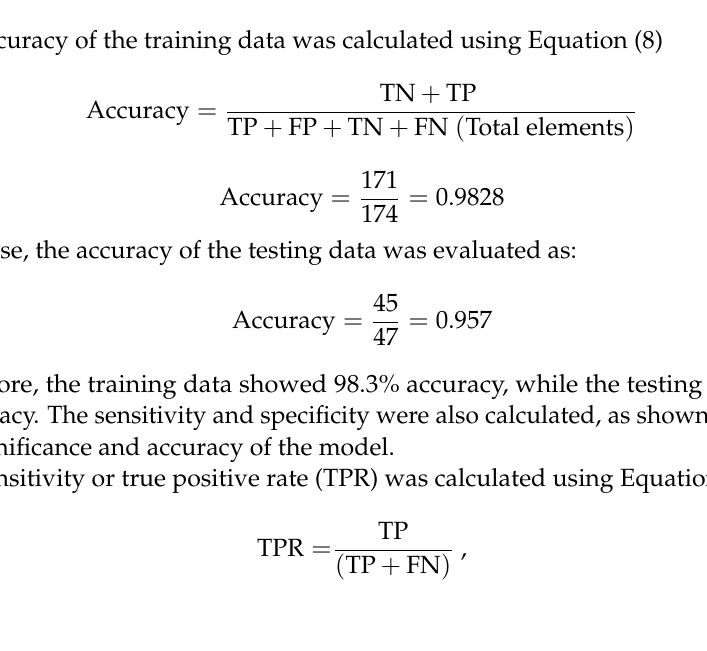
Table 10. Confusion matrix for decision tree algorithm used in assessing the best algorithm for the LEWS (Testing data).